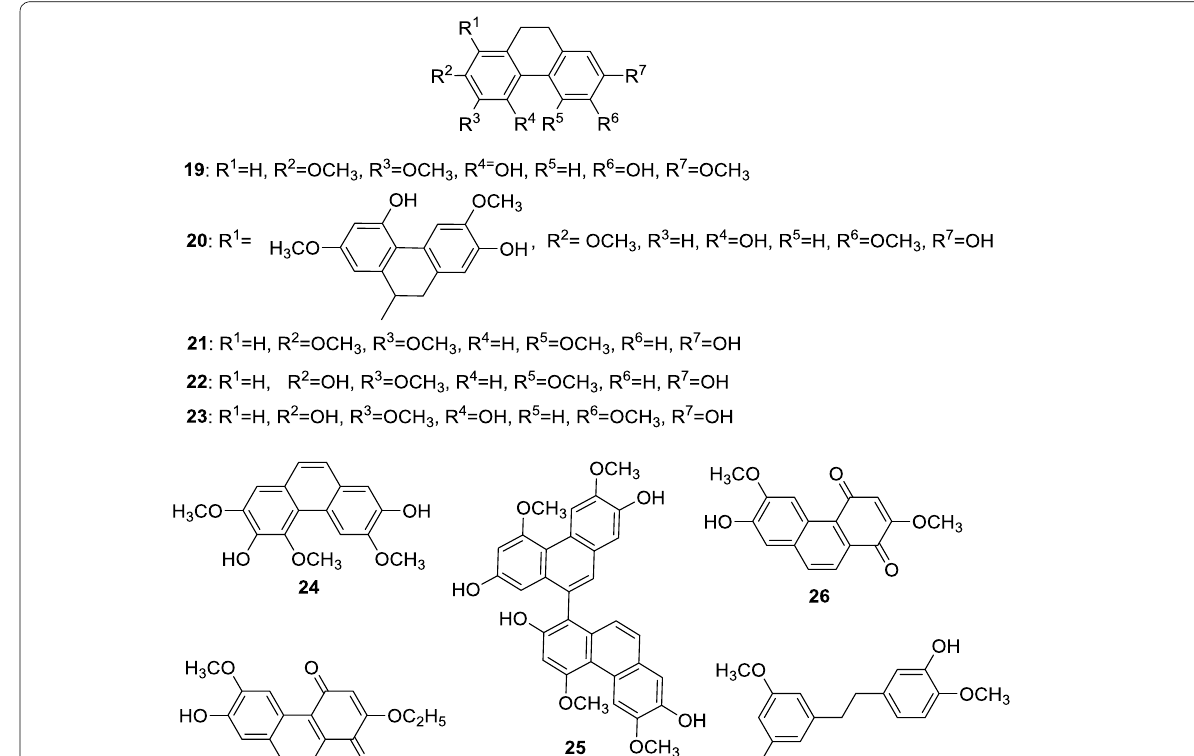
β ‑ d ‑glucopyranosyl, and Rha =